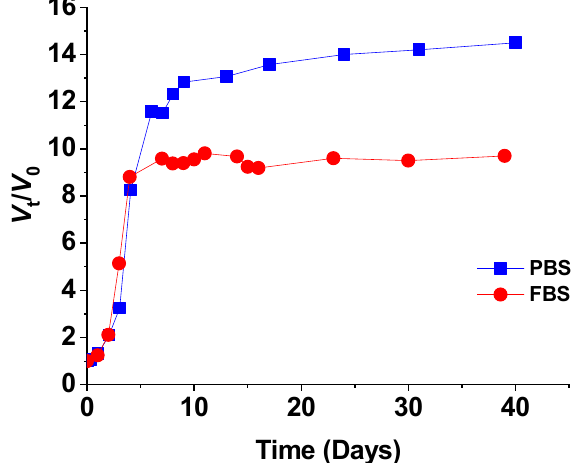
Figure 3. The time-dependence of swelling volume ratio ( V t / V 0 ) of the hydrogel polySMA-0.7 in PBS and FBS.